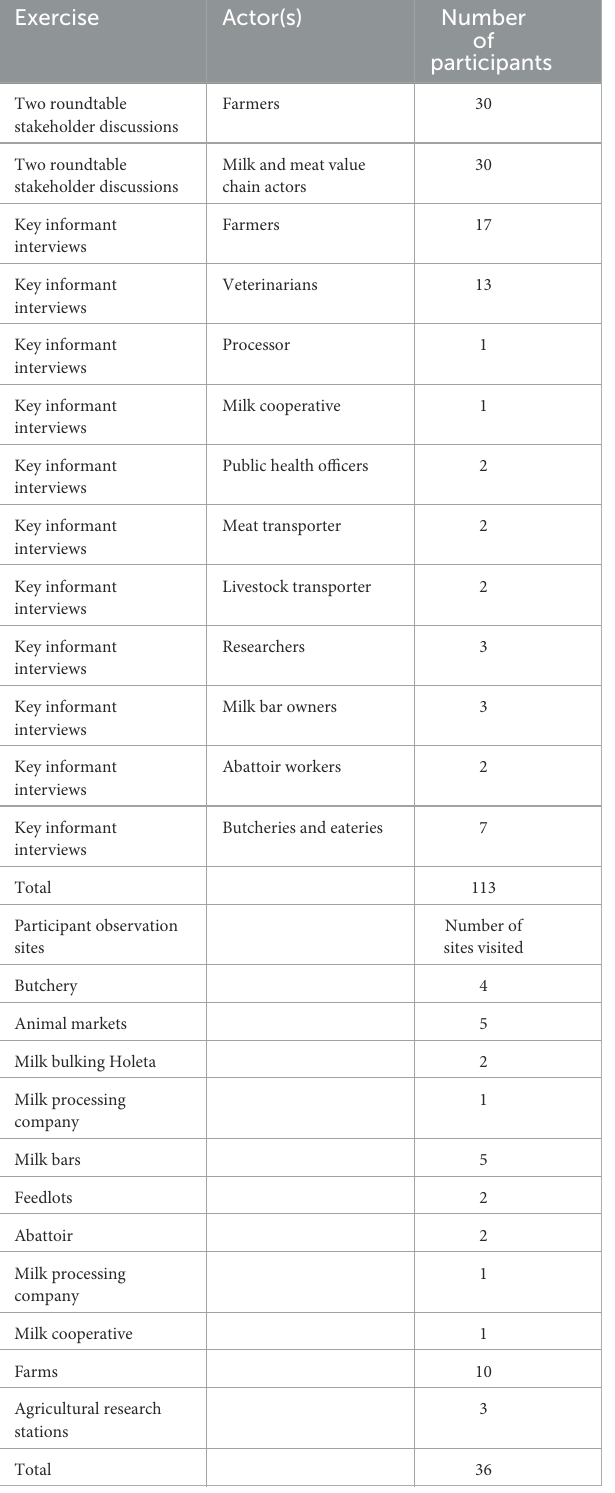
TABLE 1 Summary of research participants.